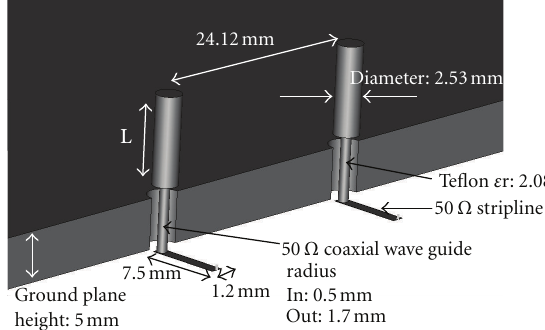
Figure 2: The monopoles are fed by a coaxial guide drilled through the